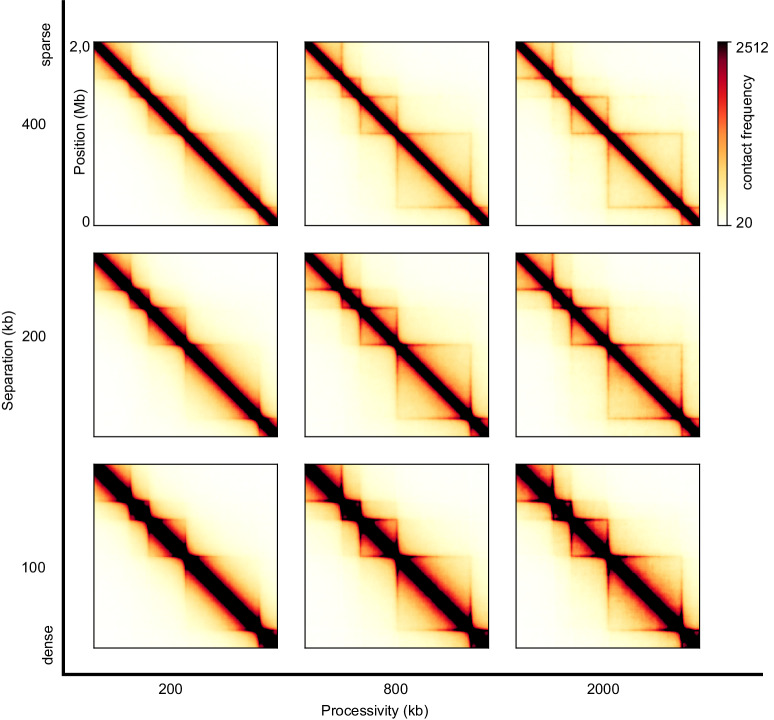
Sweep of the separation between LEFs and the processivity of LEFs for one-sided LEFs.The TAD sizes from left to right are 200 kb, 400 kb, and 800 kb respectively. A processivity of λ = 200 kb gives scalings that best match wild-type conditions, while a processivity of λ = 2 Mb results in scalings that best match Wapl depletion conditions (Figure 3—figure supplement 1).